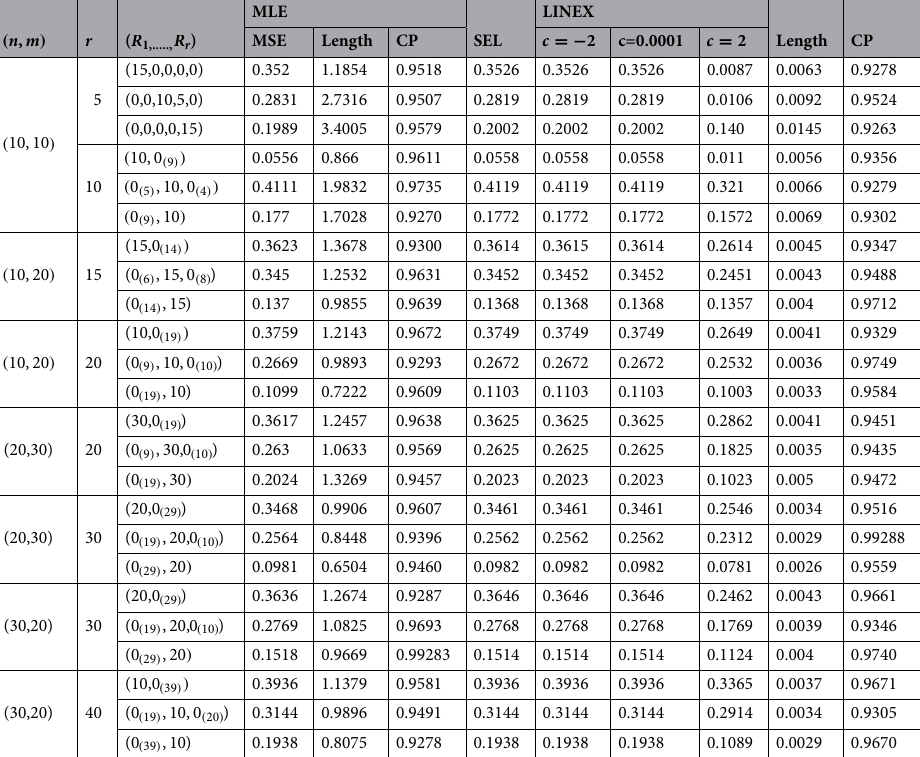
Table 6. MSE, length and coverage probability (CP) of estimates for the parameter α 2